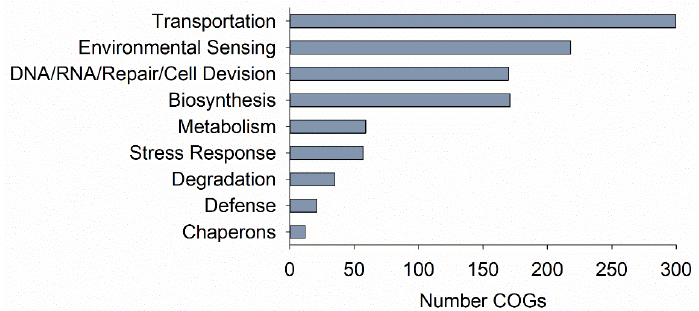
Figure 6. Number of clusters of orthologous groups (COGs) associated with different functions identified for cold-adapted protein sequences in Janthinobacterium sp. CG23_2.